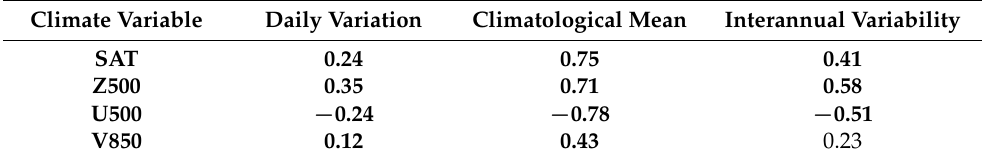
Table 1. Correlation coefficients r between ASIN and SAT (°C), Z500 (m), U500 (m / s), and V850 (m / s) in August. The bold font marks the correlations as being significant (at the 95% confidence level).